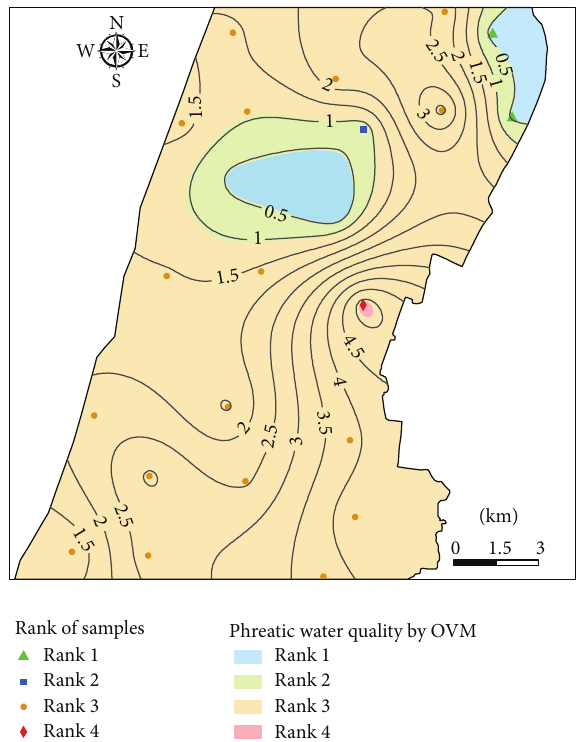
Figure 6: Contour map of osculating value and classification of the phreatic water quality by OVM with